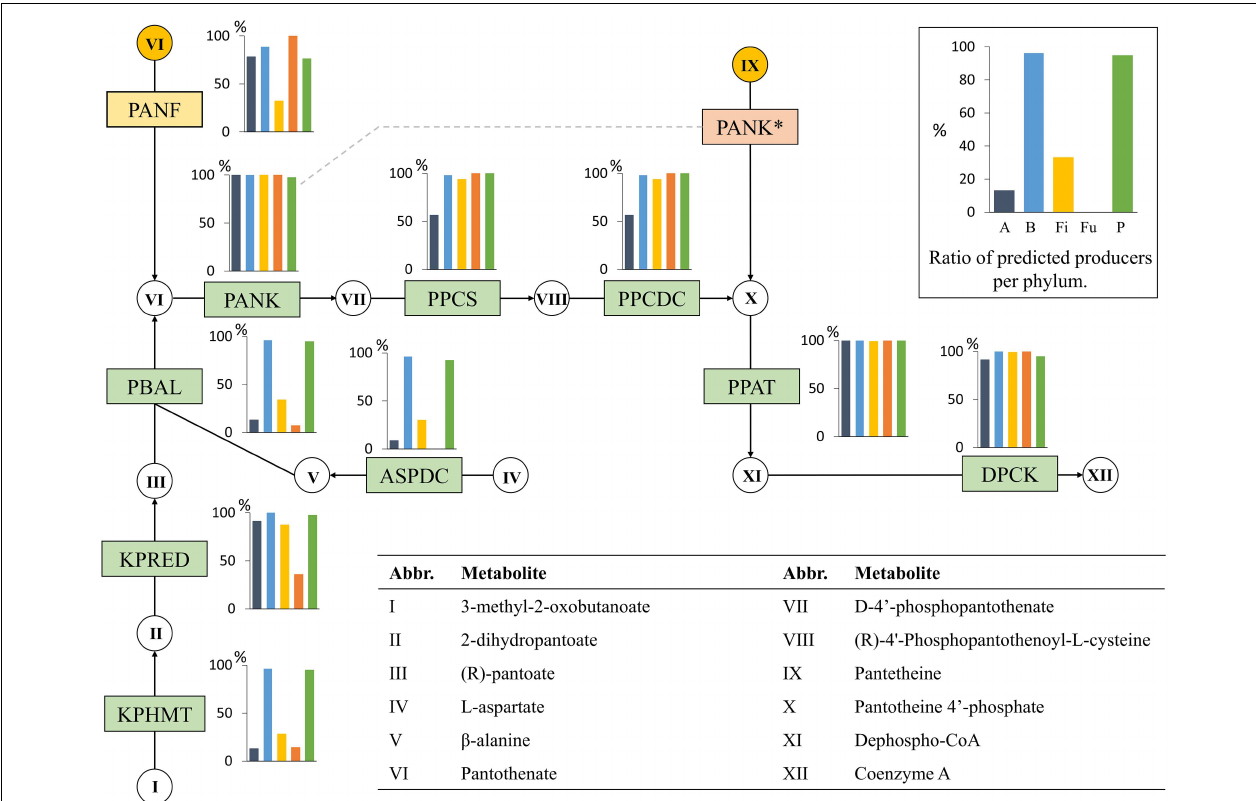
FIGURE 5 | Pantothenate biosynthesis. The pantothenate biosynthesis subsystem contains 10 functional roles (Supplementary Table 2) and 12 metabolites. Refer to Figure 1 for figure descriptions.